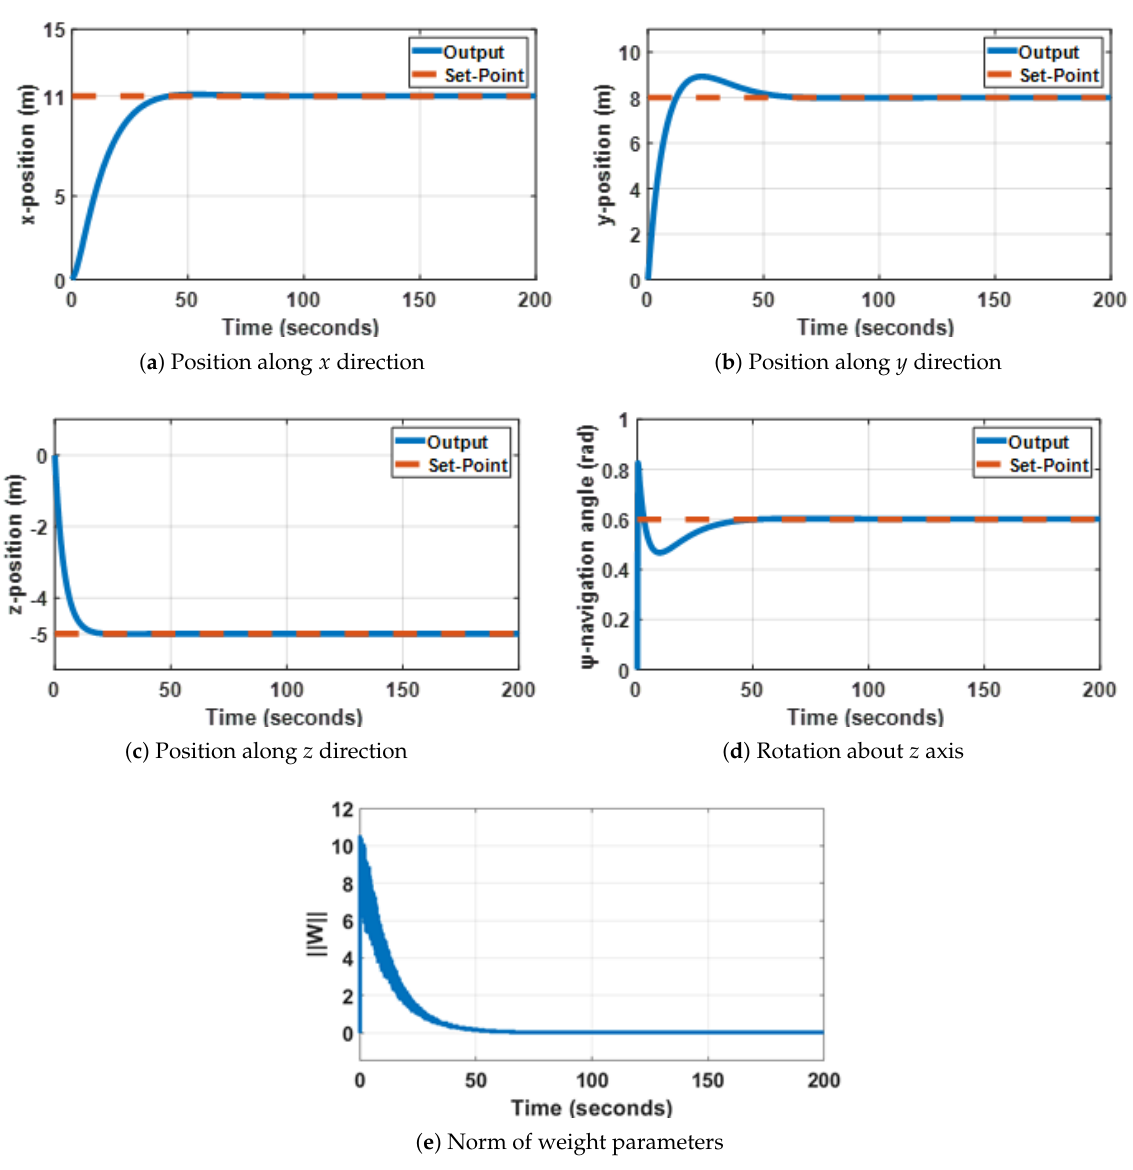
Figure 2. The out responses of the AUV system in the first experiment.